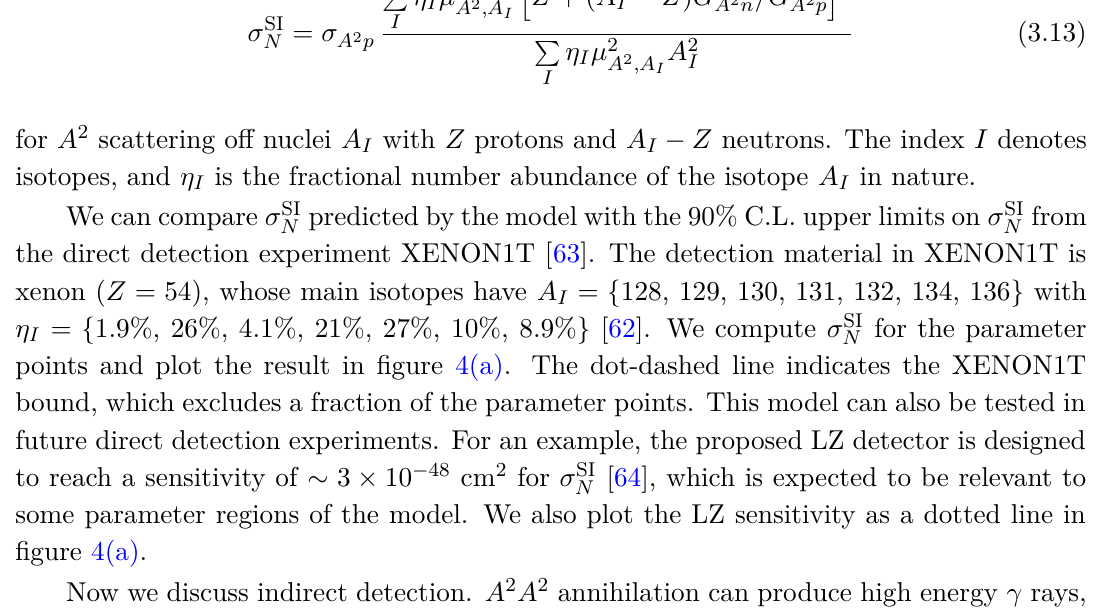
Figure 4. Parameter points projected in the m left panel, the dot-dashed line denotes the 90% C.L. upper limit on σ SI the dotted line demonstrates the 90% C.L. projected sensitivity of LZ [64]. In the right panel, the dot-dashed line indicates the 95% C.L. upper limit from the Fermi-LAT γ -ray observations of dwarf galaxies [65]. The blue points are excluded by XENON1T, the red points excluded by Fermi-LAT, the purple points are excluded by both, and the green points survive from the two